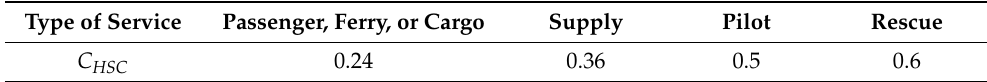
Table 7. Vessel operation type coefficients [20].